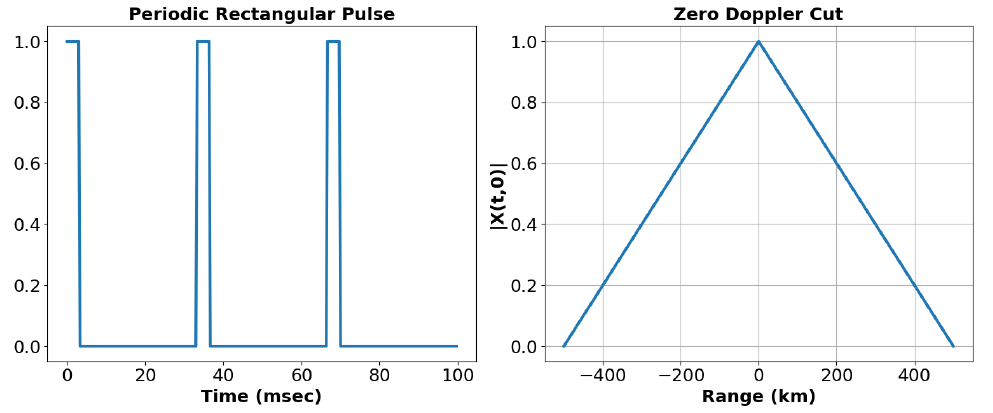
Figure 5. Rectangular pulse ( left ) and zero cut of AF ( right ).